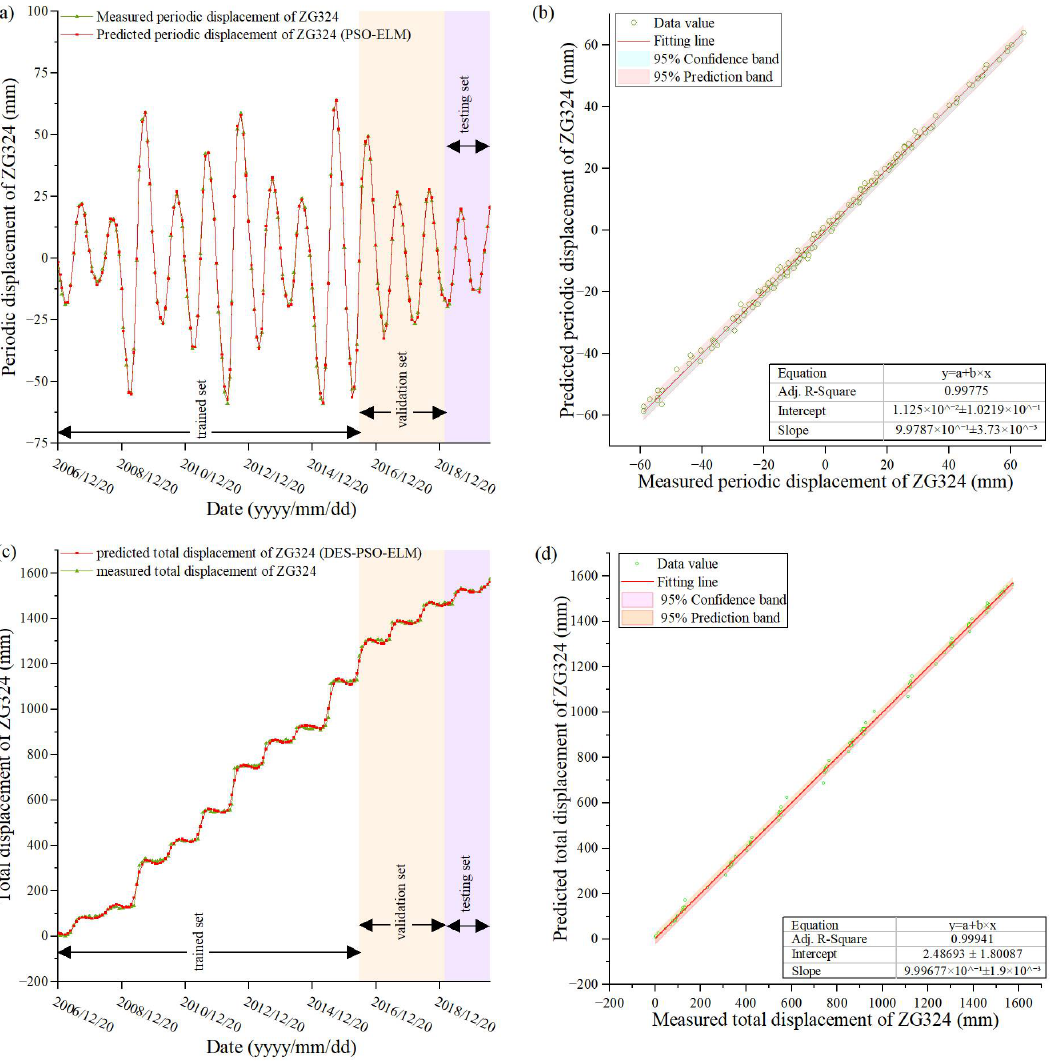
Figure 14. ( a ) Testing results of PSO–ELM for periodic displacement, ( b ) Agreement of the predicted and measured periodic displacement, ( c ) Total displacement predicted by DES–ELM and measured displacement, and ( d ) Agreement of the predicted and measured total displacement.